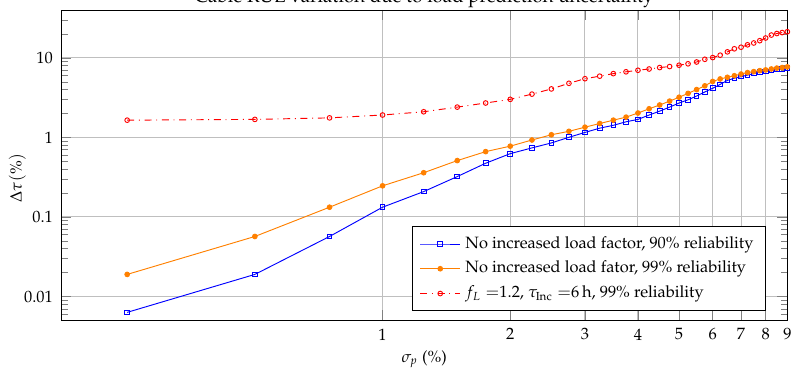
Figure 25. Expected RUL error due to load uncertainty during prognostics stage, relative to the predicted